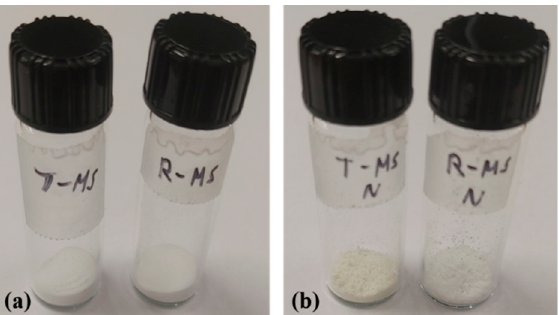
Figure 7. Images of porous silica ( a ) before the process for introducing the amine group (T-MS-0 and R-MS-0) and ( b ) after the process for introducing the amine group (T-MS-N and R-MS-N).